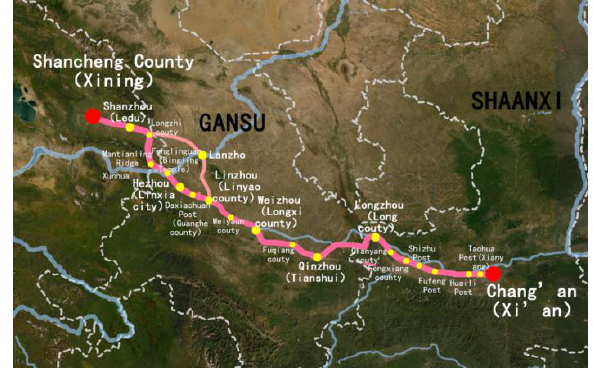
Figure 4. The east section of Tang-Tibet